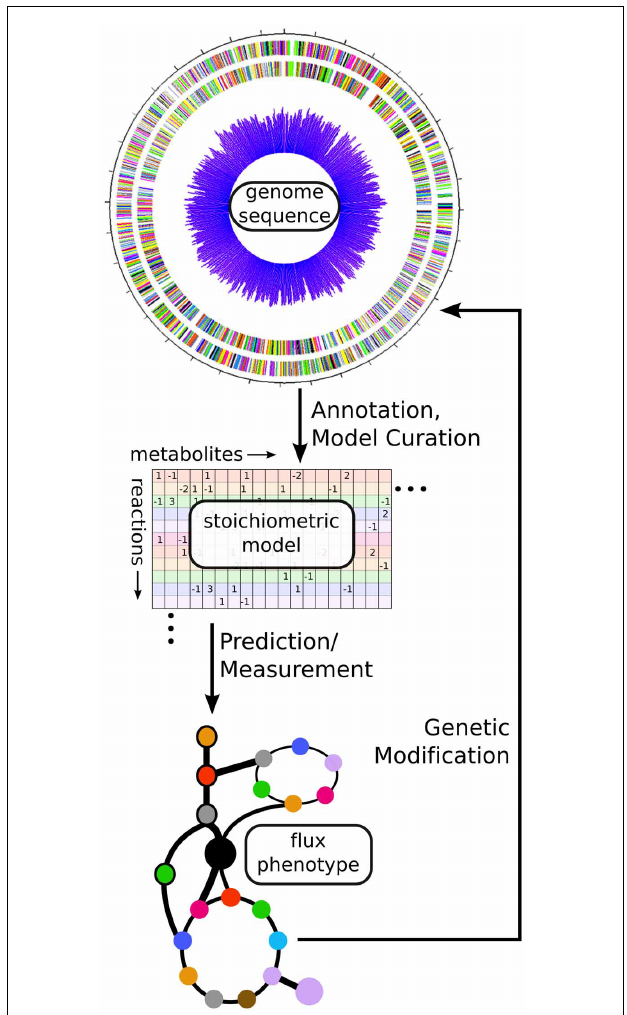
FIGURE 3 | Using fluxomics and genome scale models to link genotype to metabolic phenotype. From an annotated genome sequence, a stoichiometric model of metabolism can be constructed. That model can be solved via either prediction of an optimal flux phenotype (FBA) or measurement of actual flux phenotype ( 13 C-MFA). These results can help suggest modifications for altering the phenotype of the cell in a desired manner. In this way, a synthetic biologist can design new strains, build them using genetic modification methods, and test their phenotypes before designing new modifications in an iterative